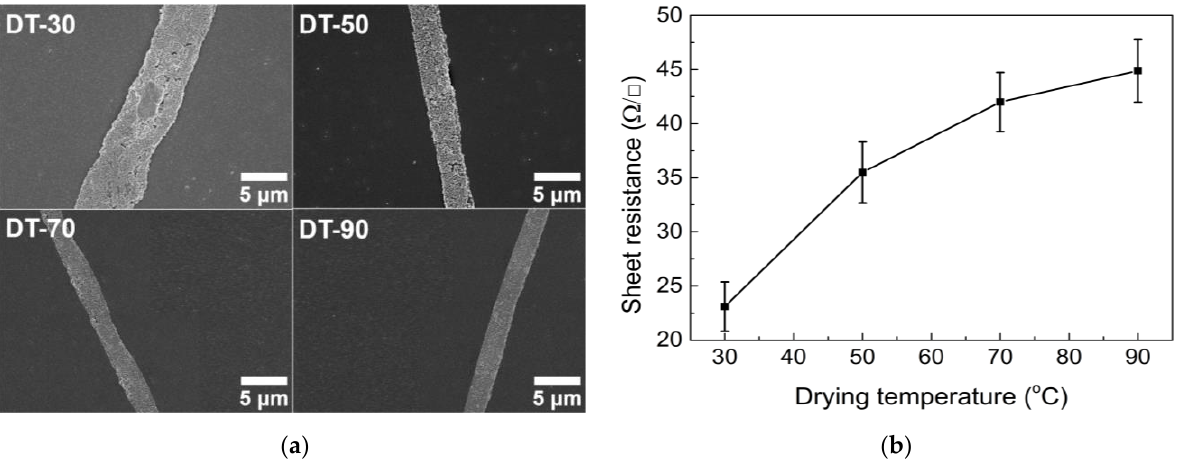
Figure 9. ( a ) SEM images of conductive lines in TCFs and ( b ) sheet resistance under different drying temperature conditions.